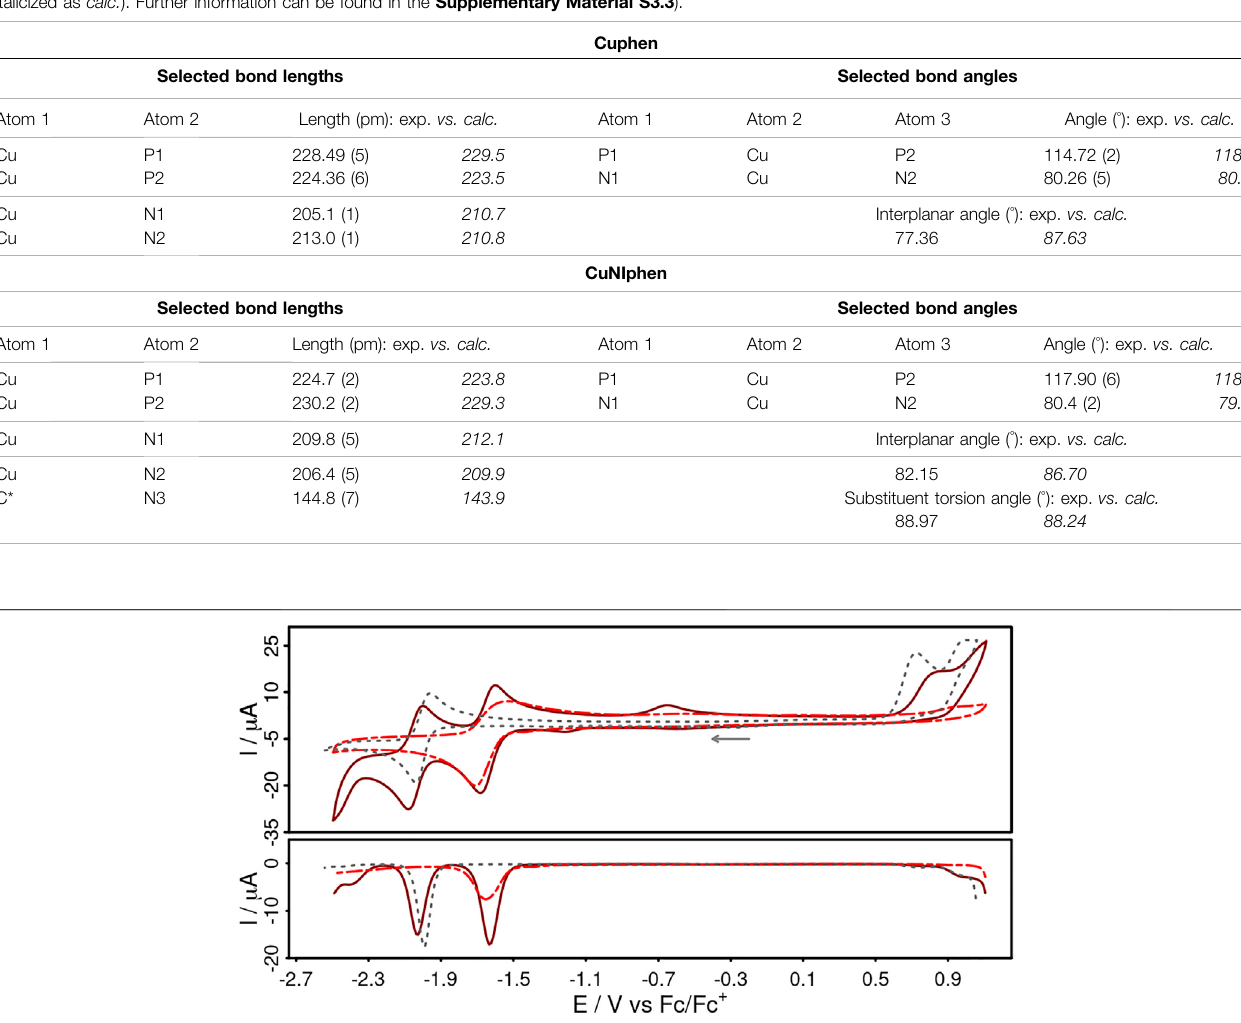
FIGURE 2 | Cyclic voltammograms (top) and differential pulse voltammograms (bottom) of CuNIphen (dark red, solid, 1 mM), NIphen (red, dashed, 1 mM) and Cuphen (grey,dotted,1 mM)inacetonitrilesolutionreferenced vs. theferrocene/ferricenium(Fc/Fc + )couple.Conditions:scanrateof100 mVs − 1 ,[Bu 4 N][PF 6 ](0.1 M)as supporting